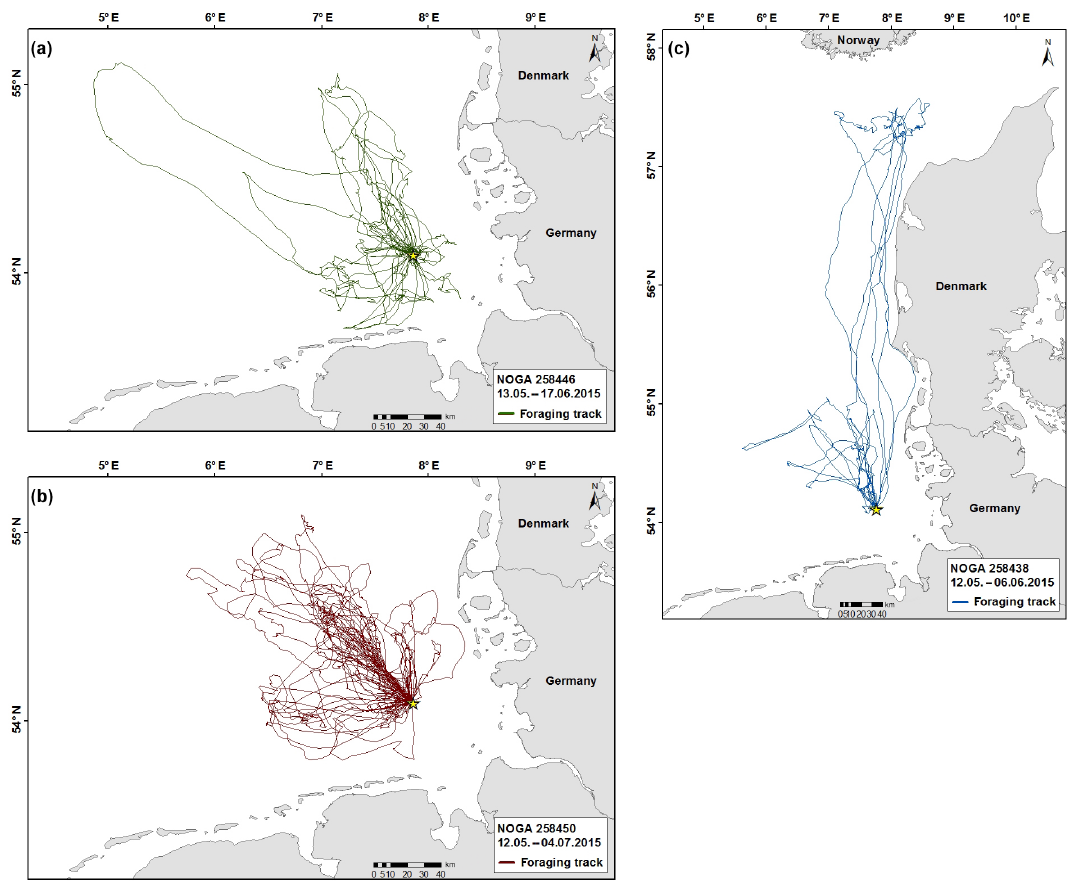
Figure 3. Flight patterns of three northern gannets (NOGAs) breeding on Heligoland in 2015. Birds were tracked over 8 (a) , 5 (b) , and 3.5 (c) weeks, respectively.